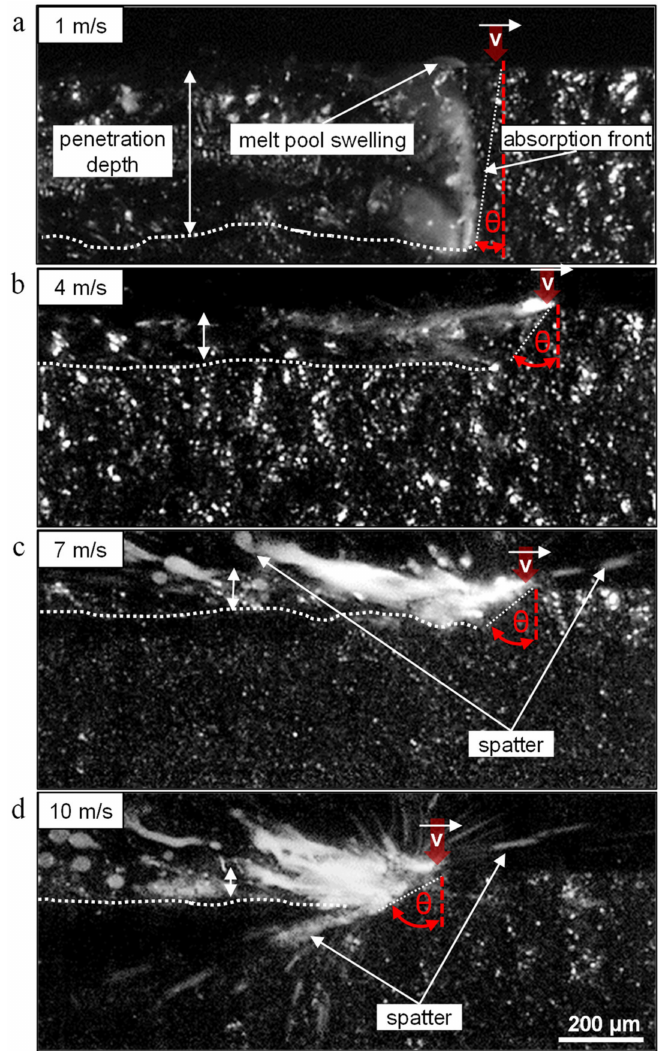
Figure 7. Comparison of inclination angle of the absorption front for different processing